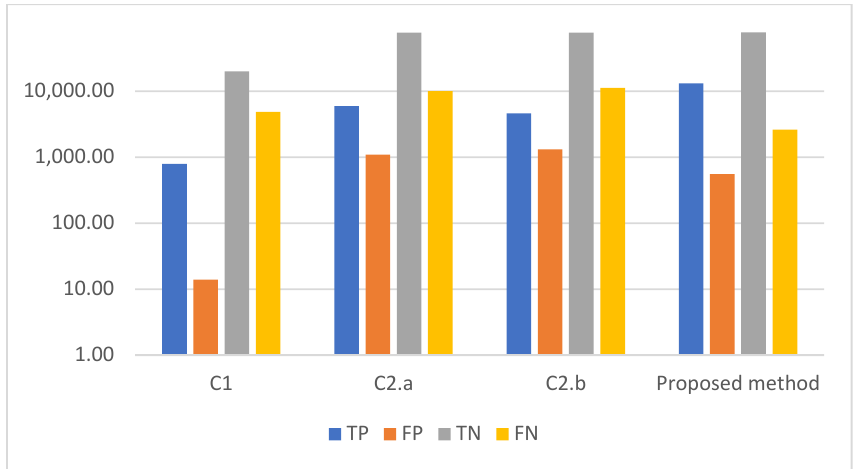
Figure 8. Comparison with other models.